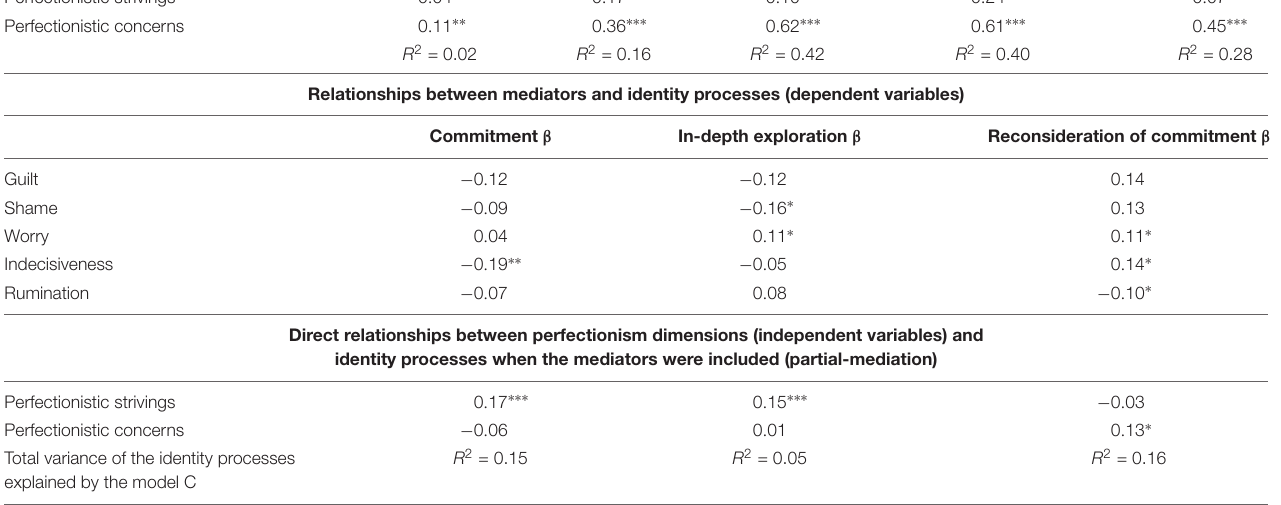
TABLE 4 | Standardized regression coefficients in the partial-mediation model (C) with the U-MICS dimensions as dependent variables (the educational domain). Relationships between perfectionism dimensions (independent variables) and mediators Guilt β Shame β Worry β Indecisiveness